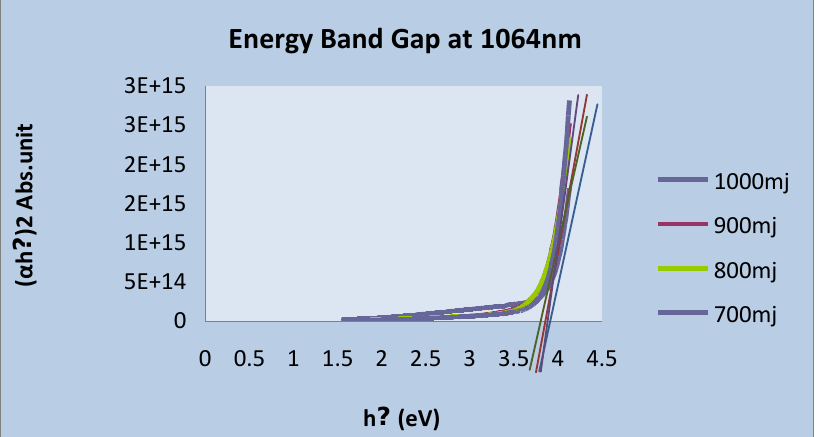
Fig.5: Optical energy band gap for ZnS/glass at different laser